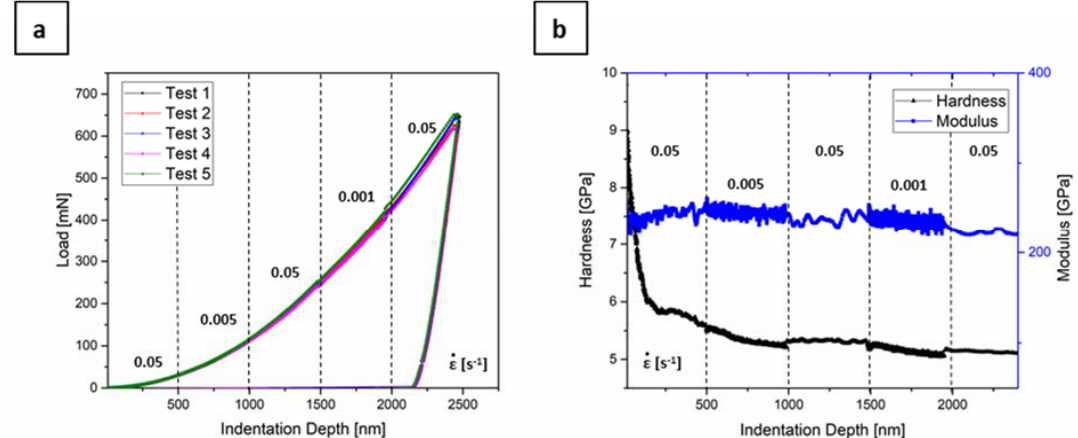
Figure 5. ( a ) Load-indentation depth plots corresponding to jump tests with 0.05 s − 1 , 0.005 s − 1 , 0.05 s − 1 , 0.001 s − 1 , and 0.05 s − 1 , with a change in the strain rate every 500 nm; ( b ) the exemplarily resulting hardness and Young’s modulus.